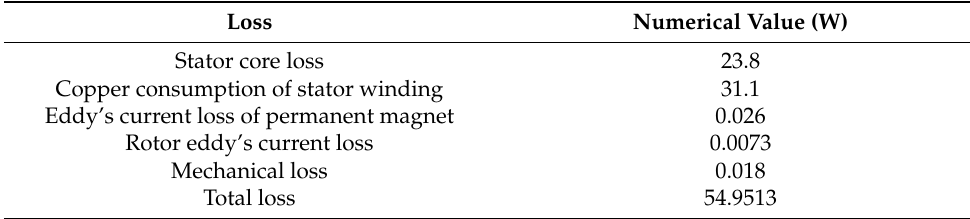
Table 1. Electromagnetic loss.